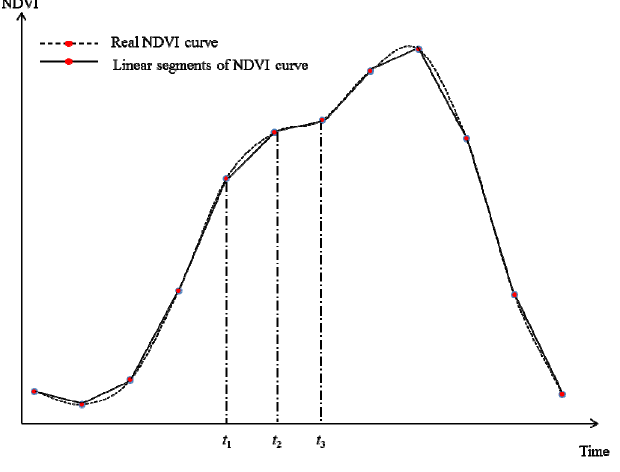
Figure 1. Schematic diagram of a NDVI growth curve and its linear